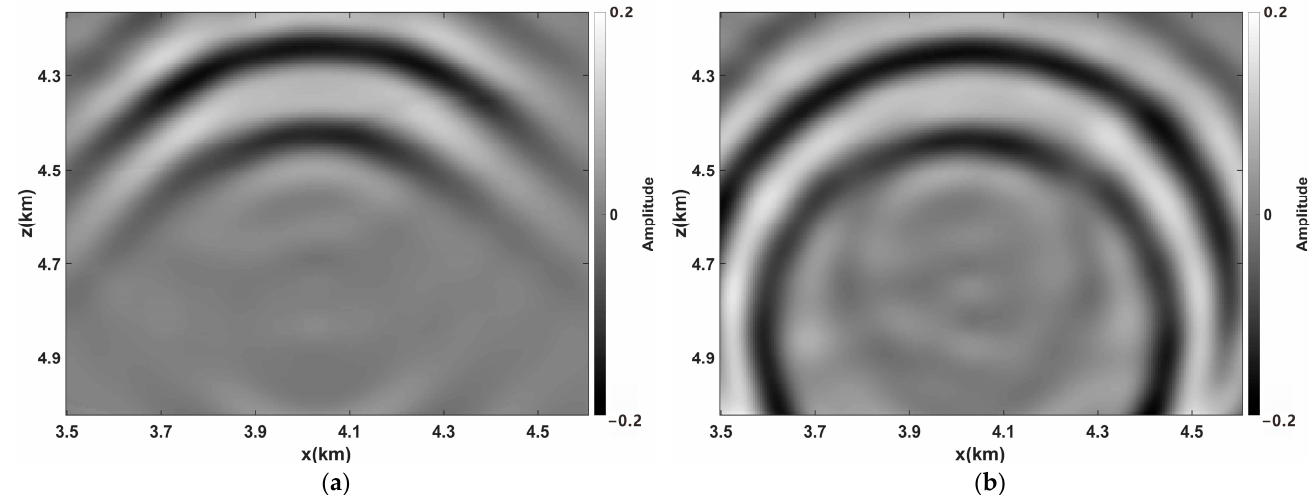
Figure 3. Wavefield snapshots of the target zone at time 1.64 s with a surface source at 4 km in X direction obtained by standard Marchenko redatuming ( a ) and forward modeling ( b ).